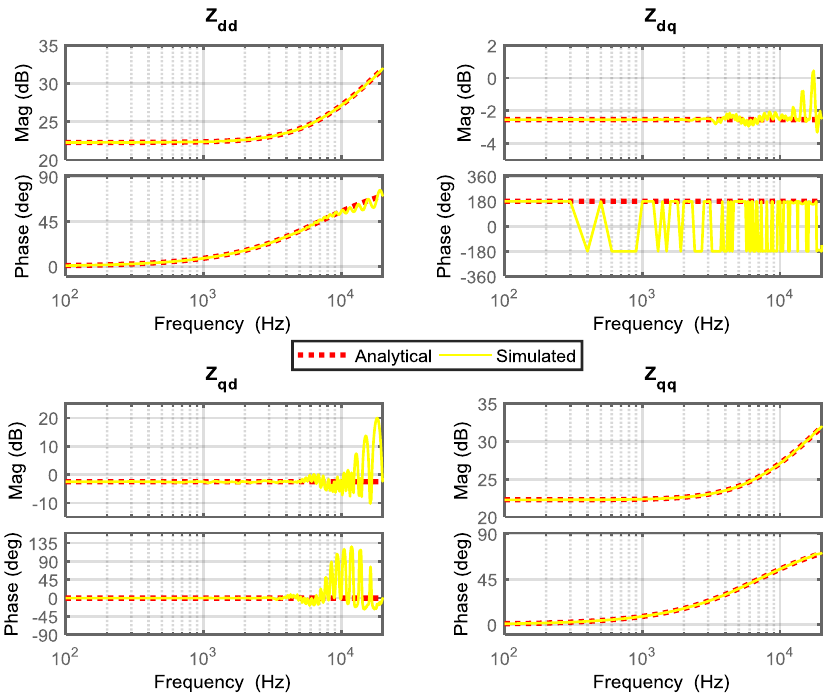
Figure 5. Comparison of Z -parameters for simulated resistor/inductor ( RL ) network using the shunt current injection approach with analytical results.